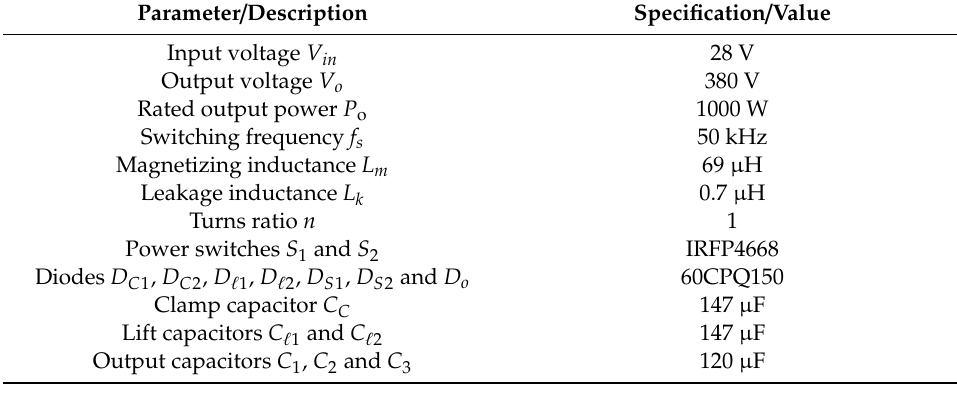
Table 2. Electrical specifications and parameters of the prototype converter.